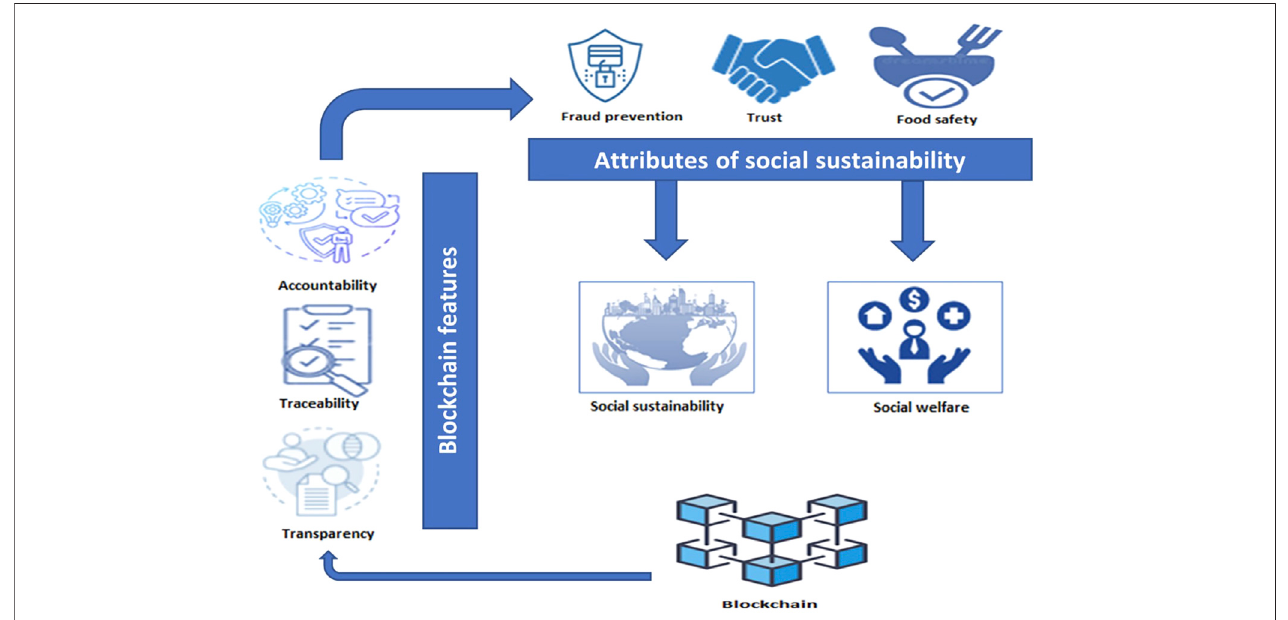
FIGURE 5 | Conceptual framework of transformation of the supply chain to attain social sustainability through